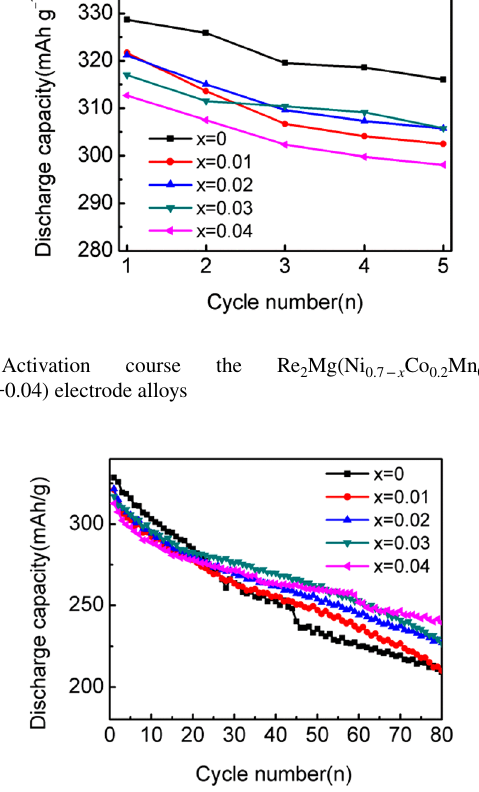
2 Mg(Ni 0.7 − x Co 0.2 Mn 0.1 Al x ) 9